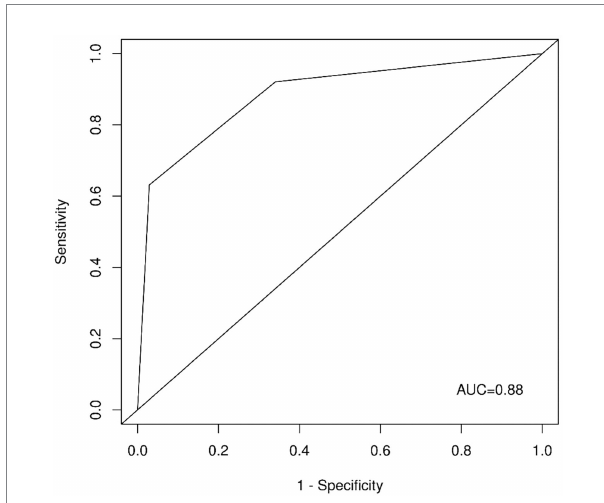
FIGURE 3 ROC curve for questions one and four. AUC-area under the